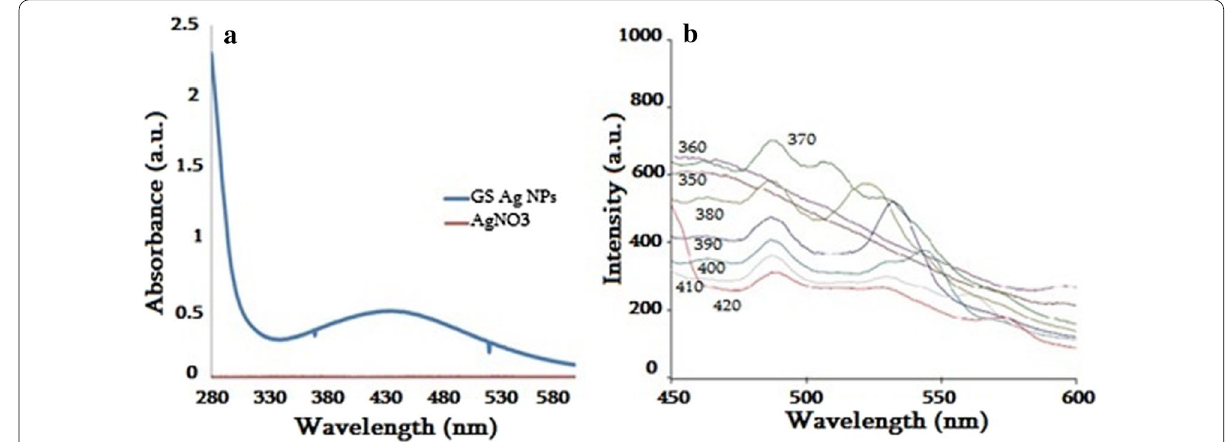
Fig. 3 UV–Vis absorption spectra ( a ) and fluorescence emission spectra ( b ) of GS Ag NPs